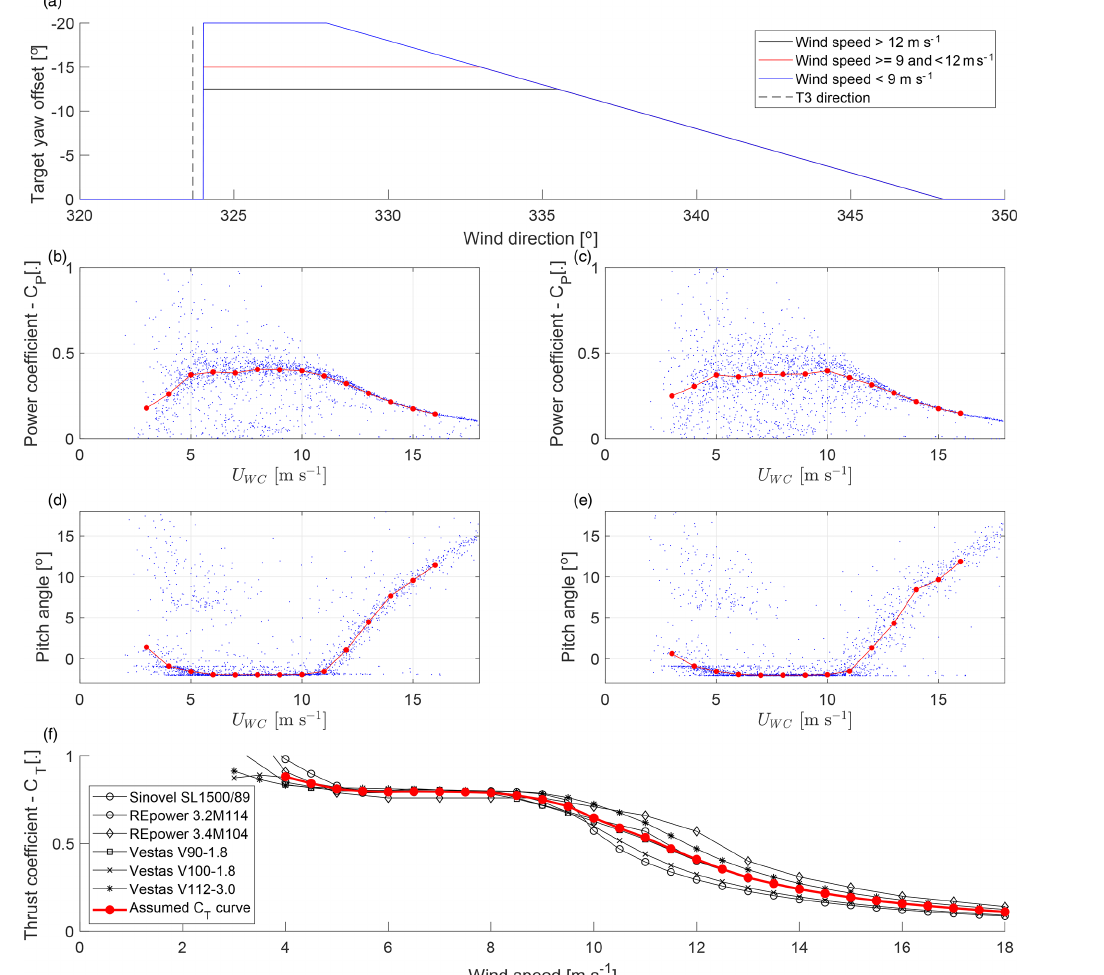
Figure 2. Characteristics of the wind turbines used in the wake-steering experiment. Panel (a) shows the target yaw offset as a function of the wind speed and wind direction for T2. Panels (b) and (d) show the 30min mean values (blue) and bin average (red) of the power coefficient and the blade pitch angle from the SCADA data of T2 as a function of the wind speed measured by the WindCube (Sect. 2.2.1). Panels (c) and (e) show the same for T3. Data from 6 January until 9 April 2019 are used in consistency with the results presented in Sect. 3. Panel (f) shows in black the thrust coefficient curves of six wind turbines from manufacturer data (first compiled by Abdulrahman, 2017) and in red the ensemble average assumed as the C T curve for